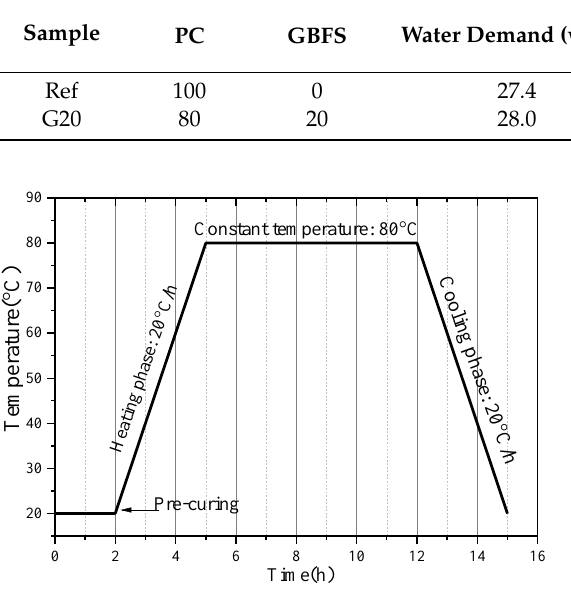
Table 2. Mix proportion (wt. %) and physical properties of GBFS blended cement.